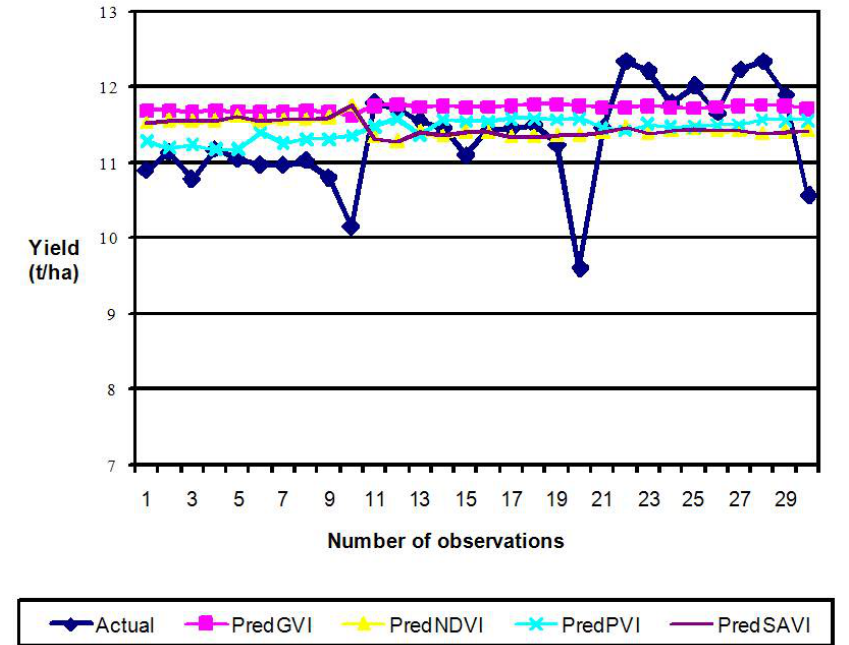
Figure 11. Comparison of VI-NN model prediction ability for the year